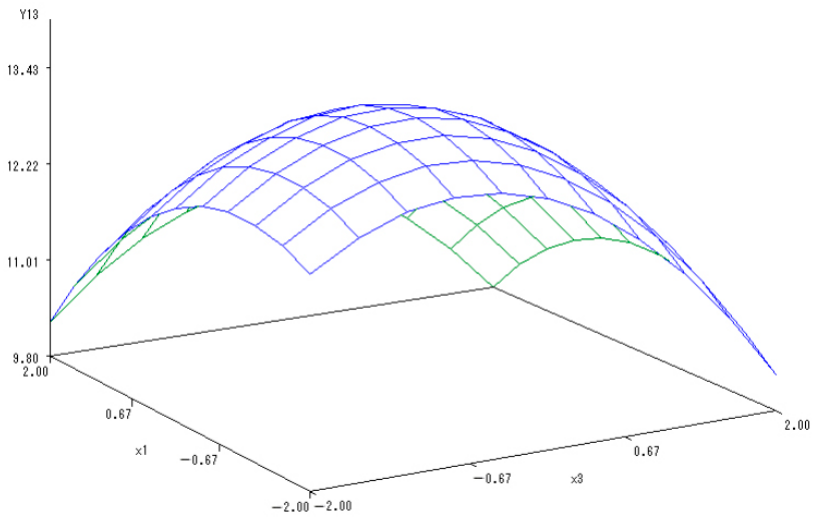
Figure 12. The 3-D map of mutual effect of N and K fertilizers application on content of soluble sugar in melon.